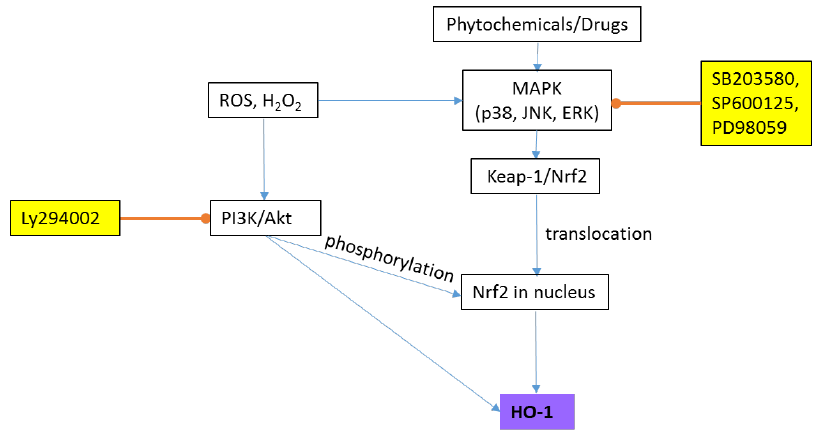
Figure 2. A simplified diagram of the regulation of ASK1-mediated apoptosis by thioredoxin (Trx) and peroxiredoxin (Prx). A (amyloid ); ASK1 (apoptosis signal-regulating kinase 1); FAD (flavin adenine dinucleotide); Fas (apoptotic receptor); JNK (c-Jun NH 2 -terminal kinases); MKP (MAPK phosphatases); NADP (nicotinamide adenine dinucleotide phosphate); P (protein); TNF (tumour necrosis factor ); ROS (reactive oxygen species); TrxR (thioredoxin reductase); ? (means that this pathway is still unexplored); 🠢 (activation); ⟜ (inhibition). Compounds in yellow boxes are inhibitors.